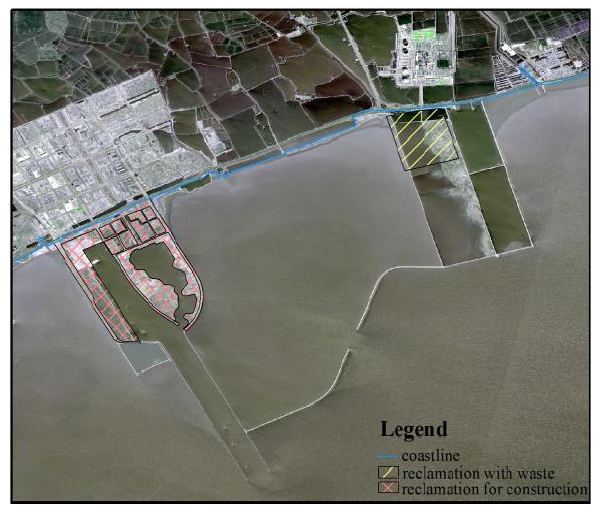
Figure 2. The sea area ownership data of the sea area